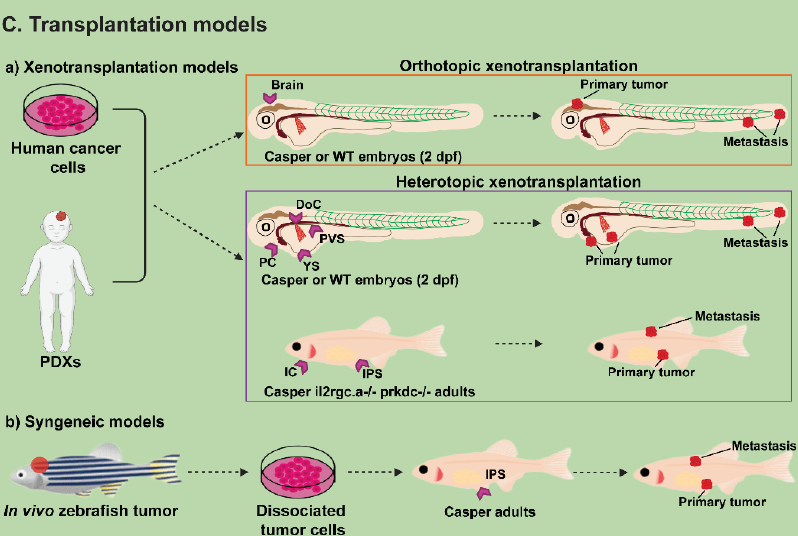
Figure 2. Paediatric cancer modelling in zebrafish involves three main approaches, ( A ) Genetic mutagenesis, ( B ) transgenesis and ( C ) transplantation models. Genetic modelling ( A ) involves the use of multiple techniques, such as historical engineered nucleases, including Zinc Finger Nucleases (ZFNs), Transcription Activator-Like Effector Nucleases (TALENs) and the current generation of engineered nucleases, and Clustered Regularly Interspaced Short Palindromic Repeats (CRISPR)/Cas9 technology with different variants, such as Cas9 and Cas12a, as well as approaches such as multi-targeting to achieve bi-allelic somatic mutations in F0 generation. Transgenesis approach ( B ) allows tumour modelling with spatial ( a ) and temporal ( b ) control on the expression of a target gene or an oncogene (ONC) of interest. Spatial transgenesis techniques, such as tol2 transposon system, Gal4/UAS and Cre-Lox, offer the tissue-specific expression of target gene with the help of a tissue-specific promotor (TSP), where temporal control is offered by Tet-on and Tet-off systems as well as the heat shock promoter, hsp70. Transplantation approach ( C ) involves the injection of human cancer cells or patient-derived xenografts (PDXs) ( a ) into 2 days post-fertilized (dpf) wild-type (WT) or casper embryos and/or immune-deficient casper adults (prkdc − / − il2rgc.a − / − ) or injecting tumour cells derived from zebrafish brain tumours ( b ) into casper adults to study tumour formation and metastasis. HDR — homology-directed repair, NHEJ — non-homologous end joining, ssODNs — single-stranded oligonucleotides, dpf — days post-fertilization.